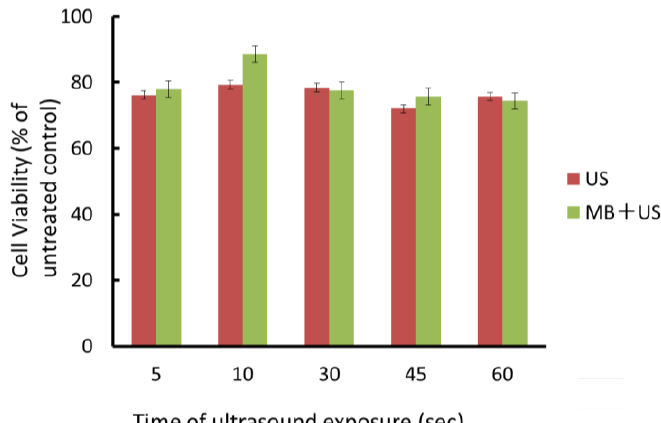
Figure 2. Effects of ultrasound on the viability of oral SCC cells. SAS cells were plated on 96-well plates and grown. They were exposed to ultrasound at an intensity of 1 W/cm 2 , and 20% duty cycle in the presence or absence of microbubbles at room temperature for various periods of time and then incubated at 37 °C for 48 h. The viability of treated cells was examined by the MTT assay. Data are means (± SD) of six determinations. US: ultrasound; MB: microbubble.